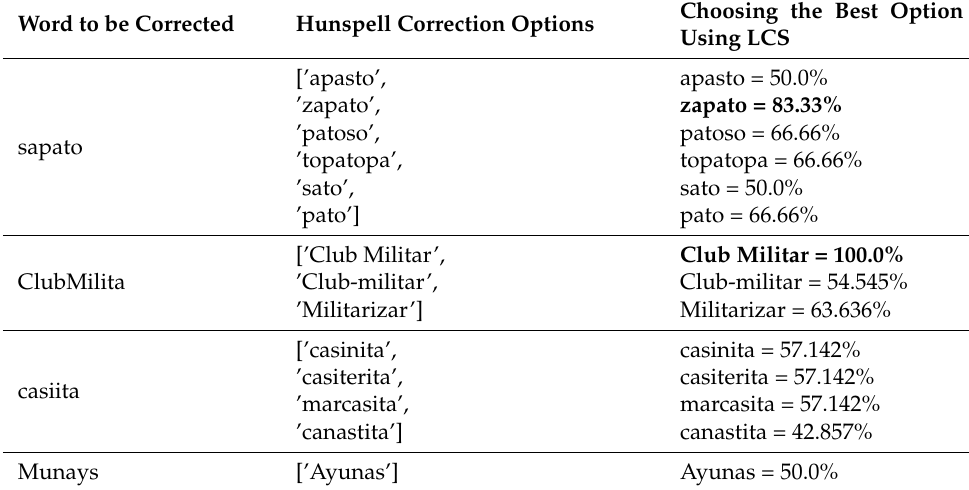
Table 5. Spell-checking process.